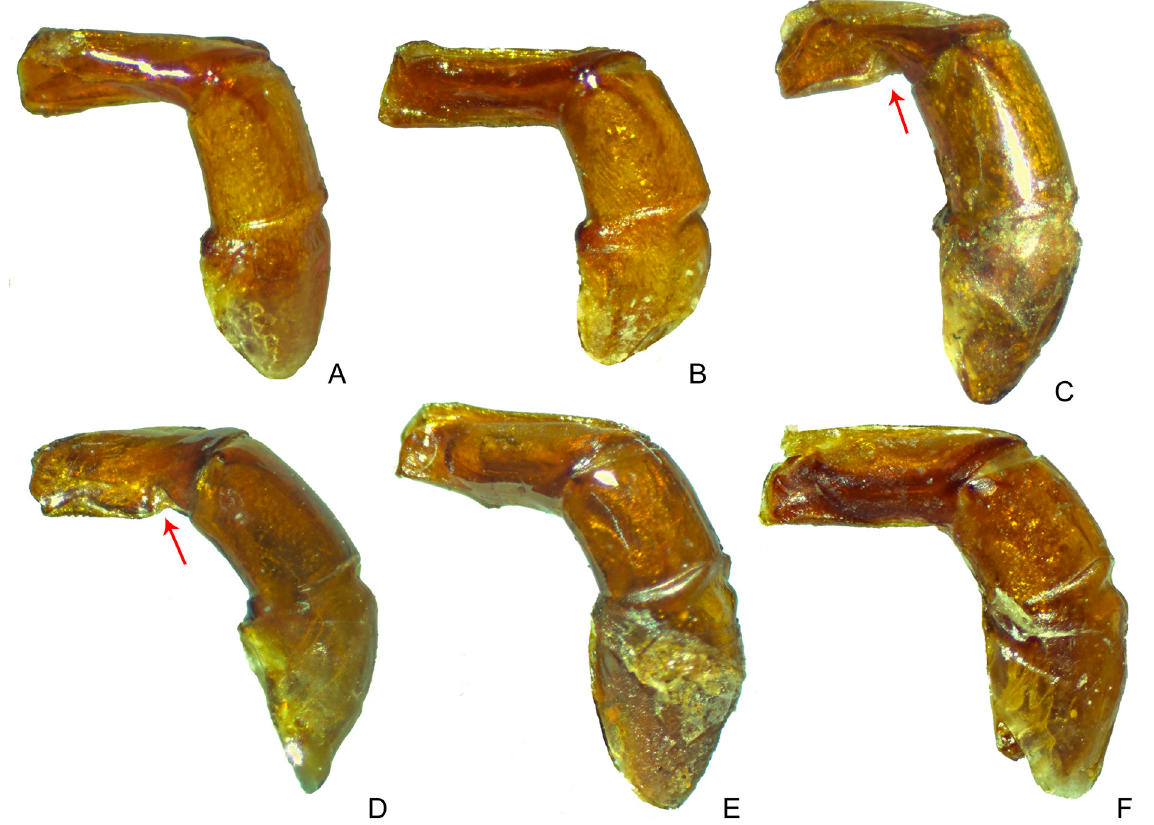
Fig. 17. Aedeagus morphological diversity in Sylvicanthon . A . S. enkerlini (Martínez et al. ,